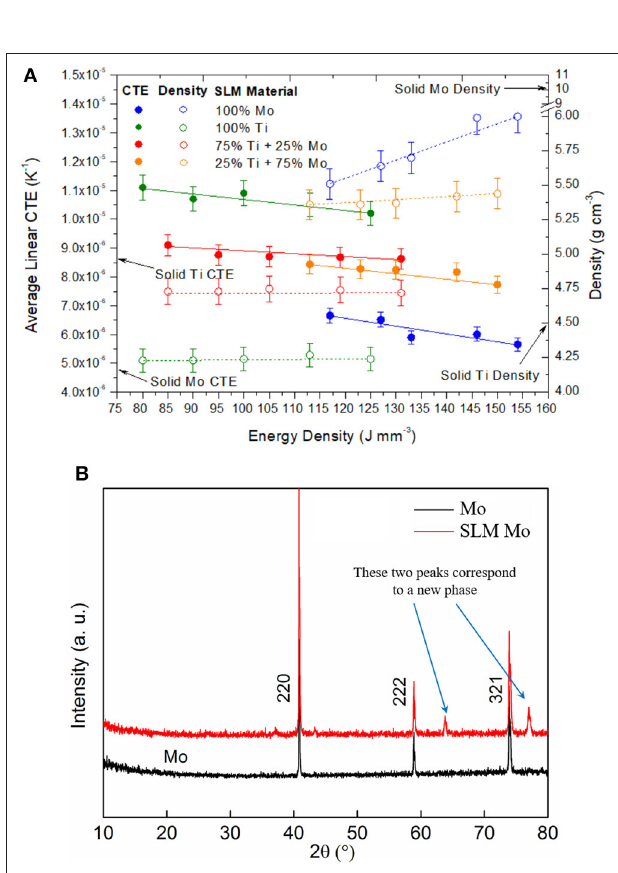
FIGURE 5 | (A) Average linear CTE and density of samples fabricated with different energy densities and (B) X-Ray Diffraction analysis of a SLM Mo sample compared with typical